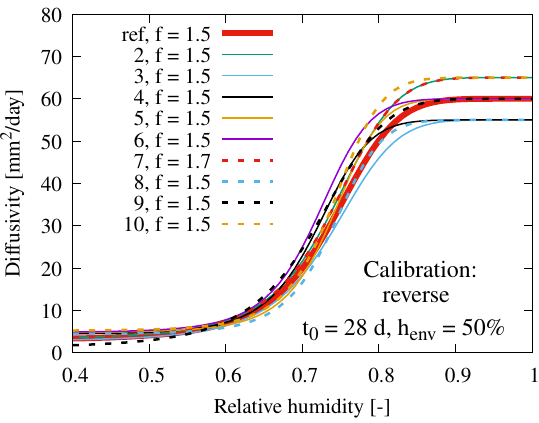
Figure 11. Di ff usivity functions calibrated in- versely on the evolution of curvature of 75 mm thick slab drying from one side ( h env = 50, t 0 = 28 days) obtained from the simulation with the reference set of material